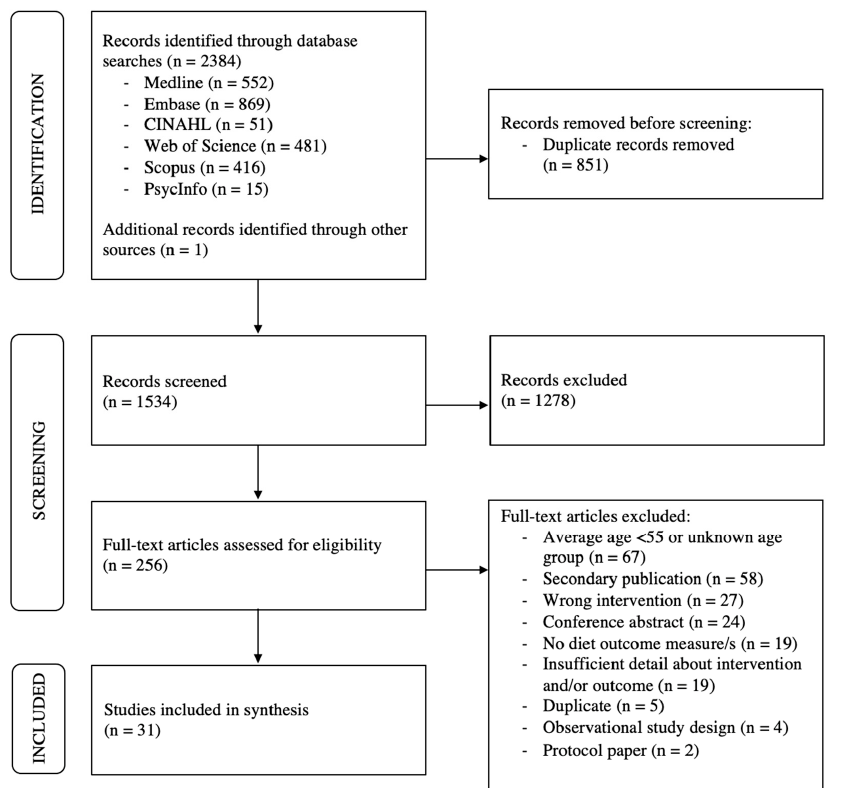
Figure 1. Preferred Reporting Items for Systematic Review and Meta-Analyses Extension for Scoping Review (PRISMA-ScR) of included articles [19].